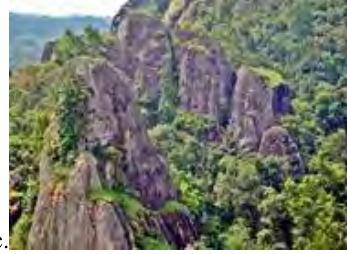
c. Figure 10(c) landscape in Nglanggeran (projsct02,